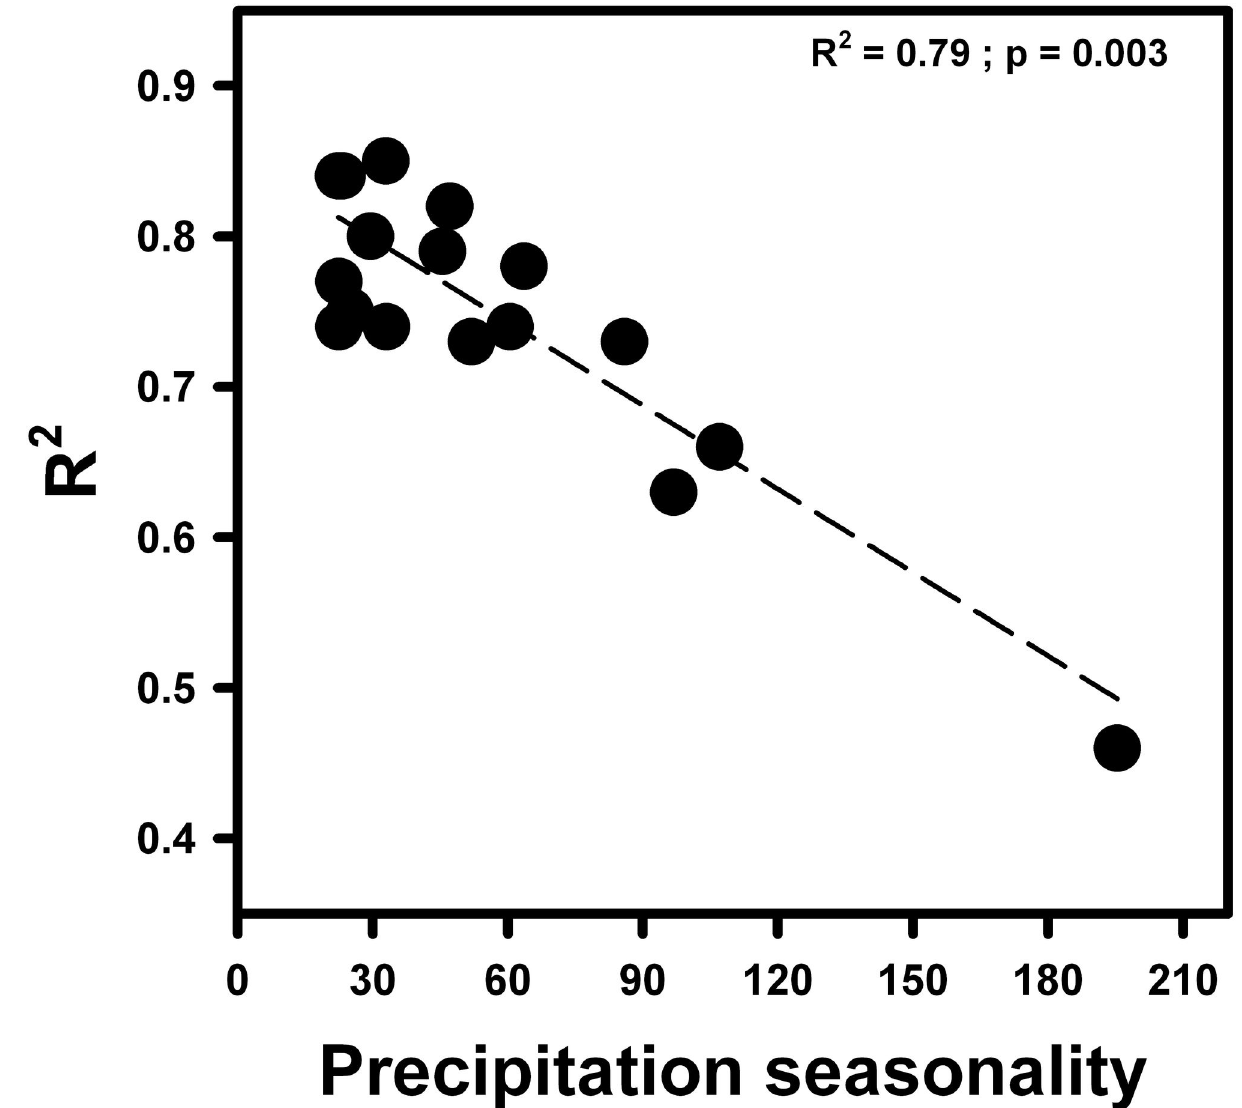
Figure 3. Pearson correlation between adjusted R-square and precipitation seasonality in 17 different populations of Taraxacum officinale distributed